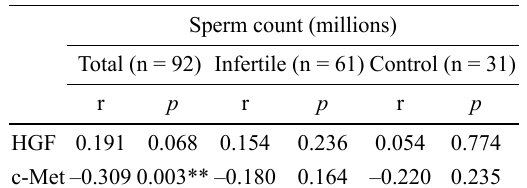
Table 4. Correlation between sperm count and HGF and c-Met expression levels.